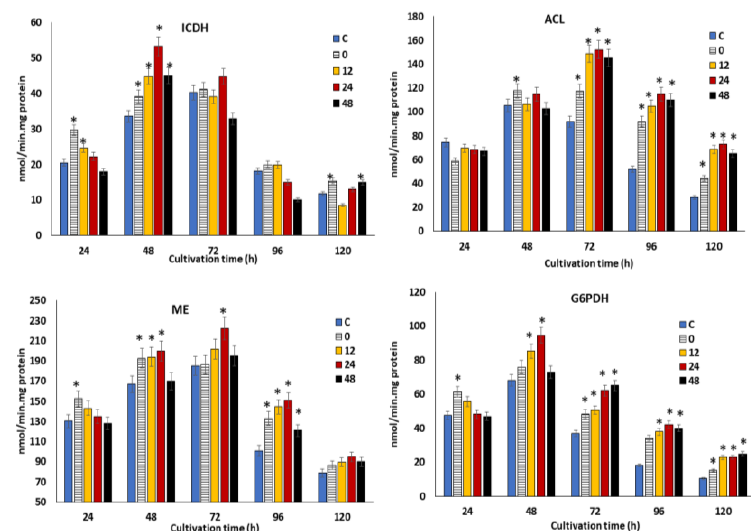
Figure 5. The impact of the synergistic optimal concentration of KIN, JA and GA on ICDH, ACL, ME and G6PDH at the 0, 12, 24 and 48 h feeding points in SW1.Values and error bars represent the means and the standard deviations of triplicate experiments ( n = 3). (*) represents the statistical significance with respect to control values at p <